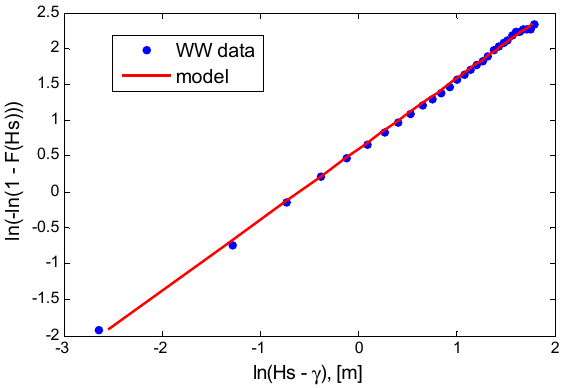
Figure 6. Parameter Weibull parameter fit for marginal distribution of Hs. (E 14.5–N 44.0).